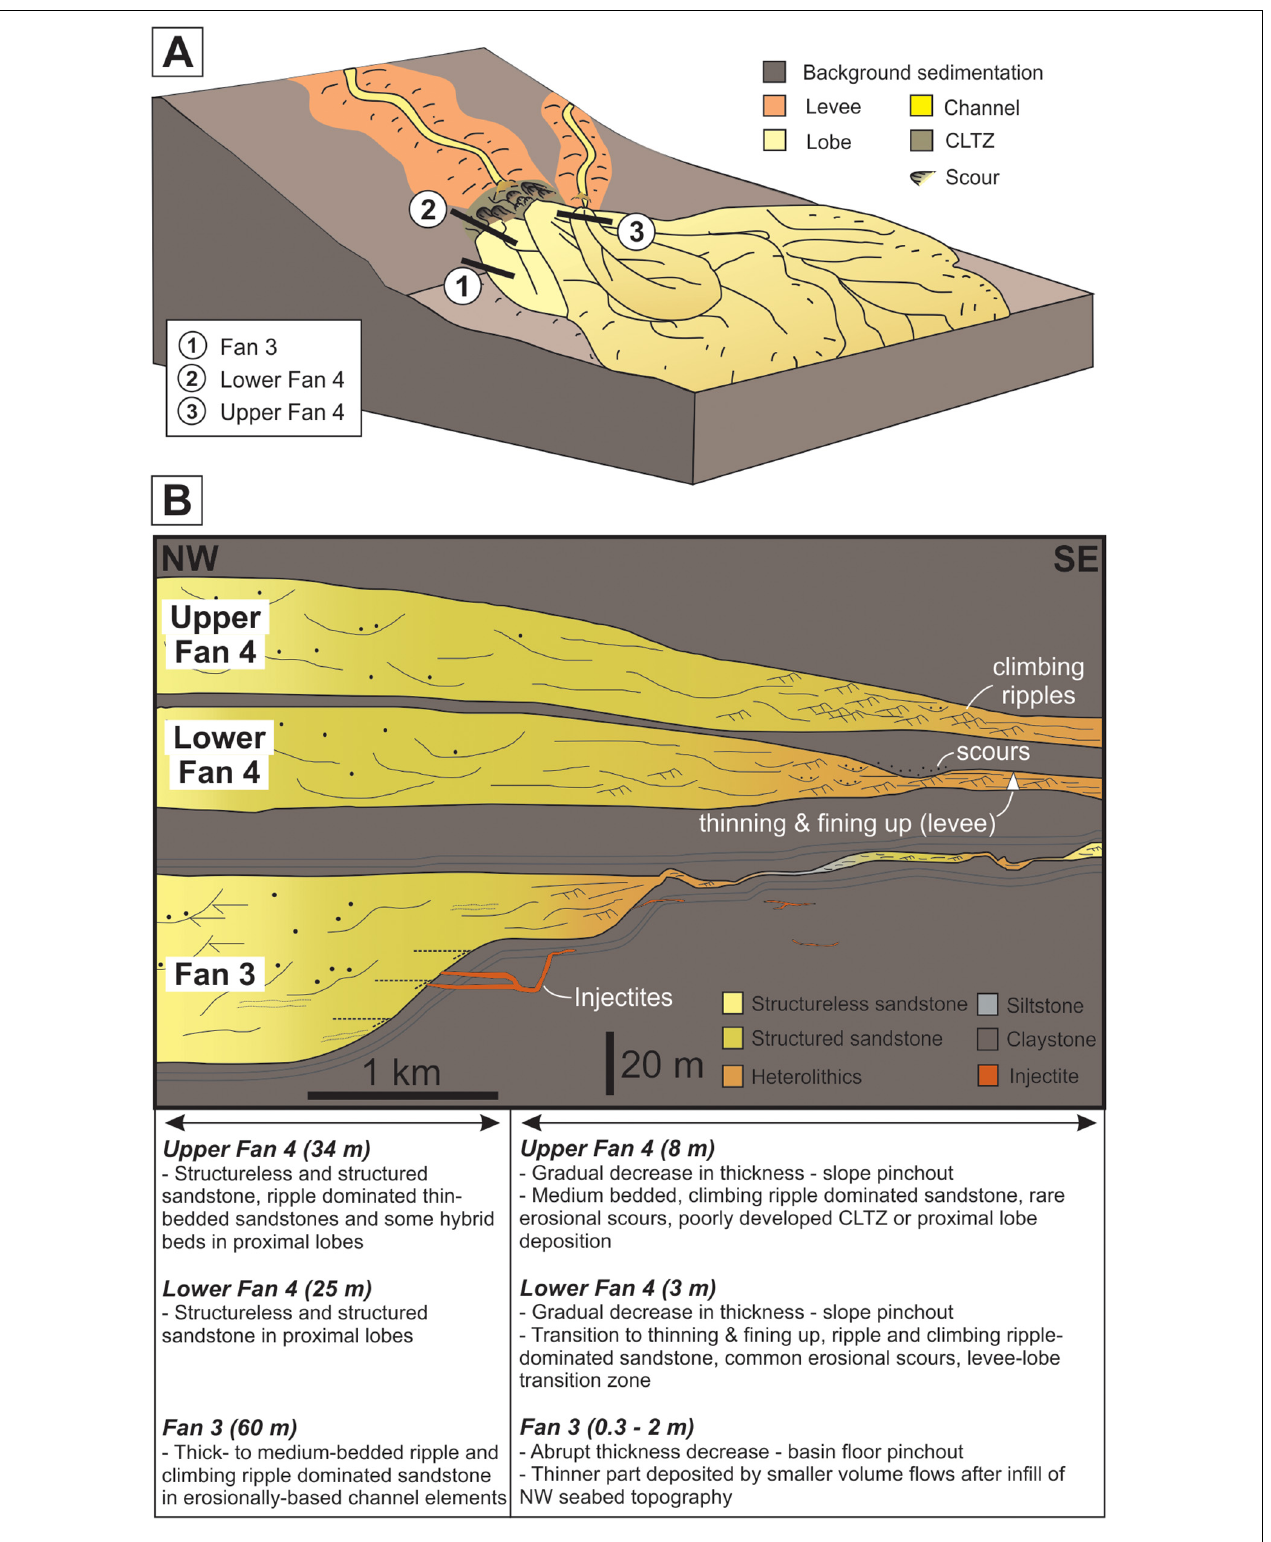
FIGURE 13 | (A) Schematic summary of a deep-water slope to basin floor transition, indicating the location of the oblique up-dip pinchouts of Fan 3, lower Fan 4 and upper Fan 4. (B) Schematic cross-section of the oblique up-dip pinchouts of Fan 3, lower Fan 4 and upper Fan 4, indicating the changes in pinchout architecture between these lobe complex sets. The table includes a summary of the facies and thickness changes toward the pinchout.